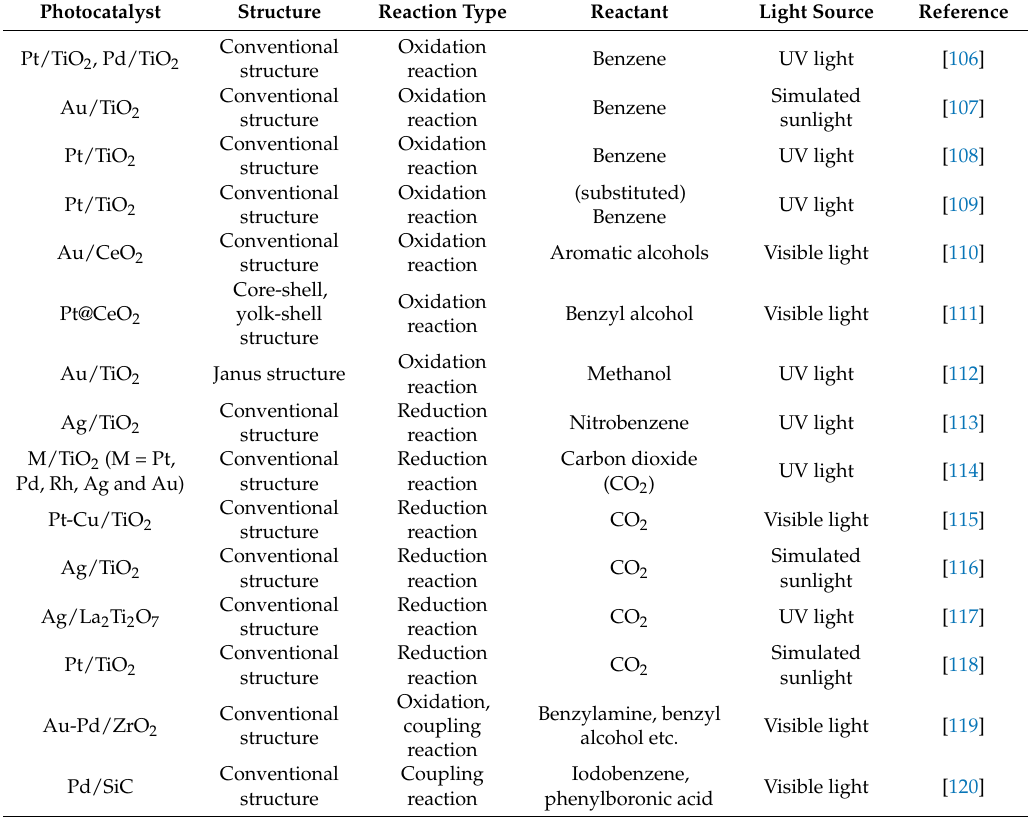
Table 2. M/S nanocomposite photocatalysts for selective organic